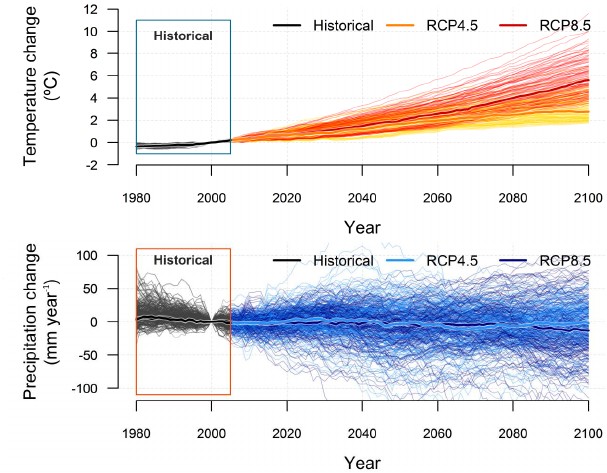
Figure 4. Changes in mean air temperature and total annual precip- itation related to climate change for the nine general climate models and the two climate change scenarios for the all the studied meteo- rological